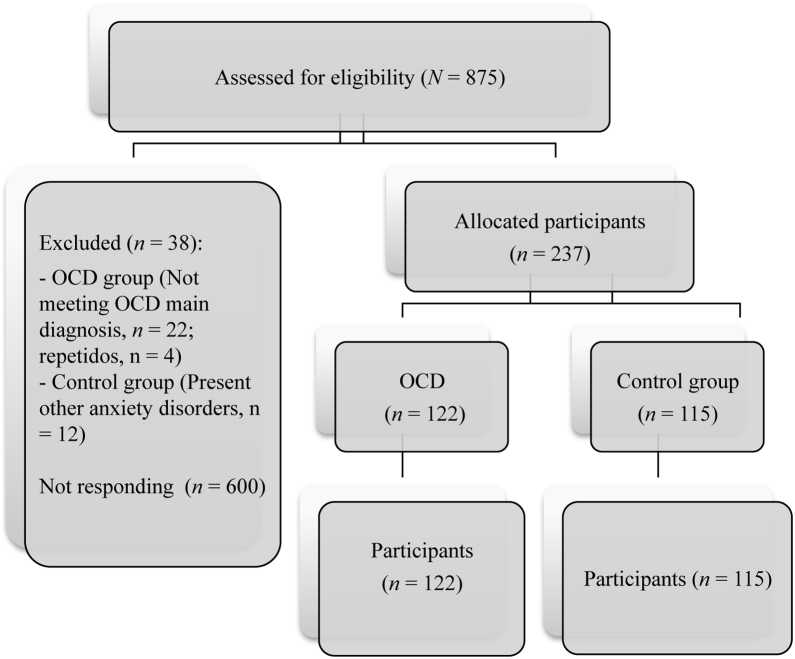
CONSORT Flow diagrams of study development.